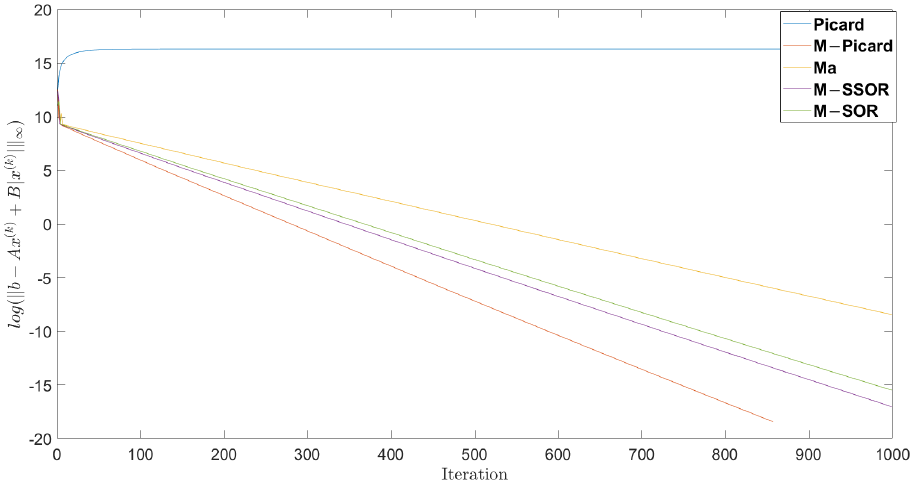
Figure 5. The Rate of